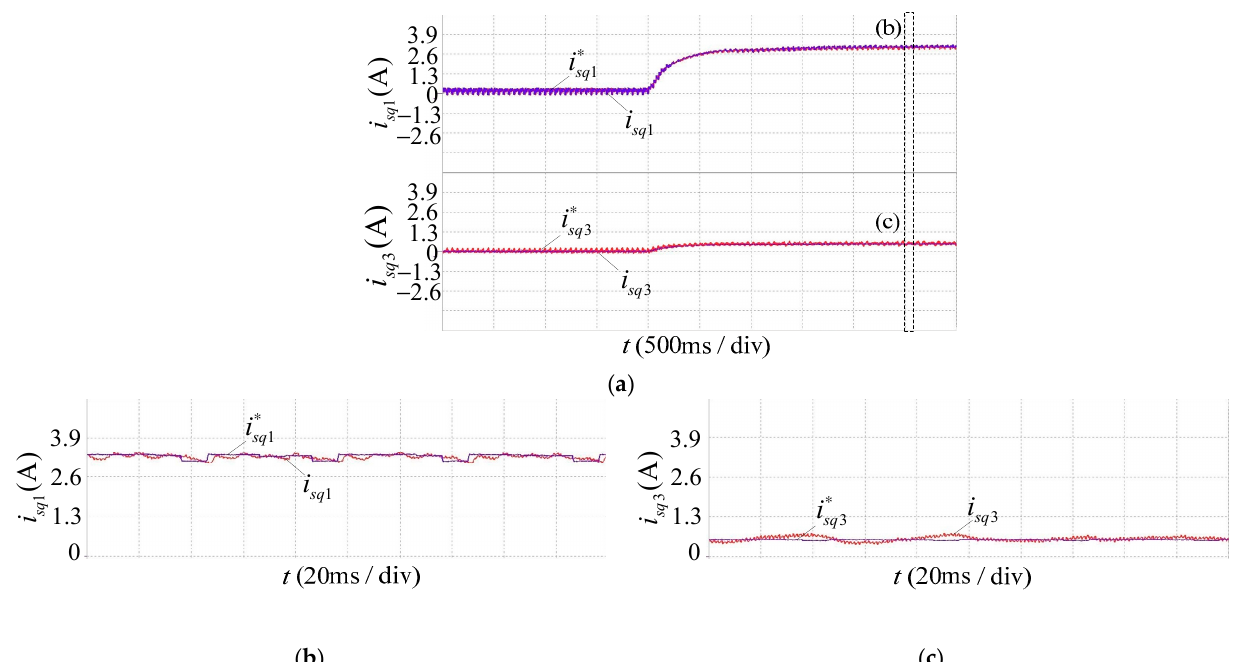
Figure 10. The inductance is 0.8 times the actual value for ( a ) the whole process; ( b ) the current i